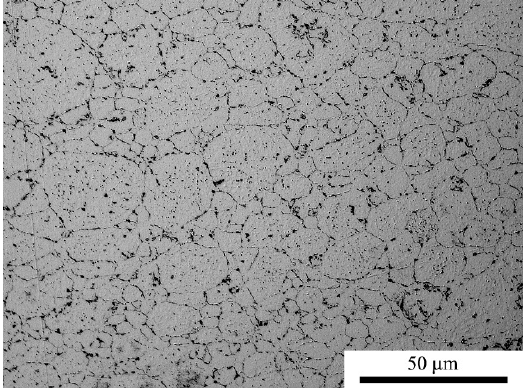
Figure 11. Microstructure of AA6061 (SPS sinter).